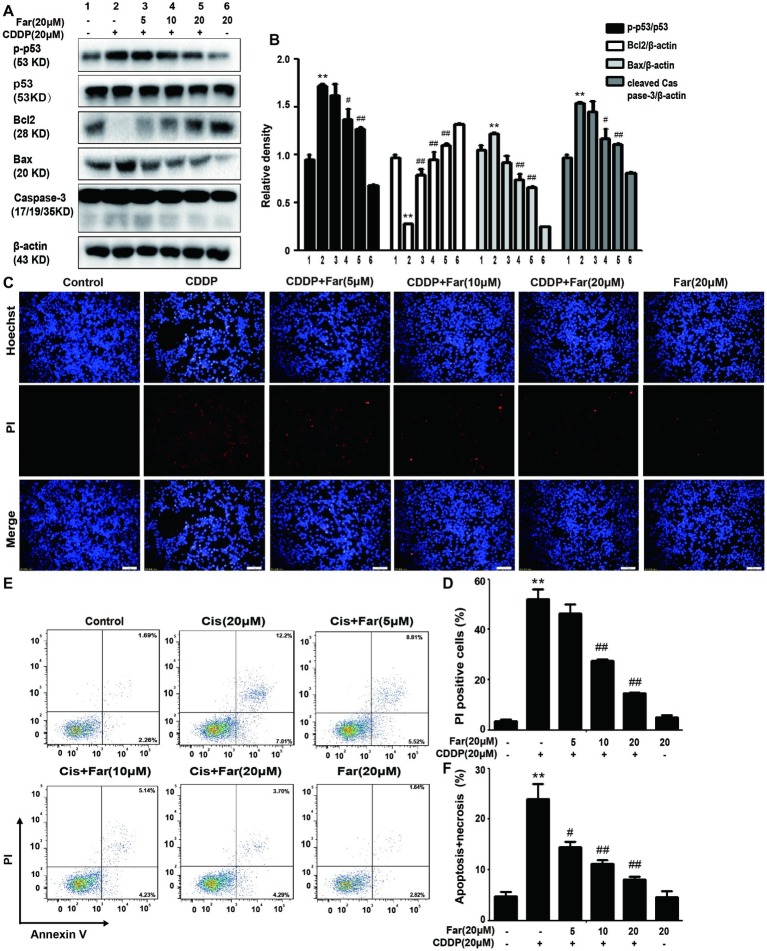
Effects of farrerol on inhibition of the apoptosis of cisplatin-treated MTECs. MTECs were plated in six-well plates, preincubated with farrerol (5, 10, or 20 μM) for 1 h and then stimulated with cisplatin (20 μM) for 18 h. (A,B) The expression of the representative proteins p-p53, p53, Bcl2, Bax, and caspase-3 was assessed by Western blotting. (C,D) MTECs were stained with Hoechst/PI for 15 min, and the fluorescence was then rapidly detected with a fluorescence microscope. (E,F) The percentages of apoptotic and necrotic cells were determined by flow cytometry. All experiments were duplicated three times. *p < 0.05 and **p < 0.01 vs. the control group; #p < 0.05 and ##p < 0.01 vs. the CDDP group. β-actin was used as an internal control.